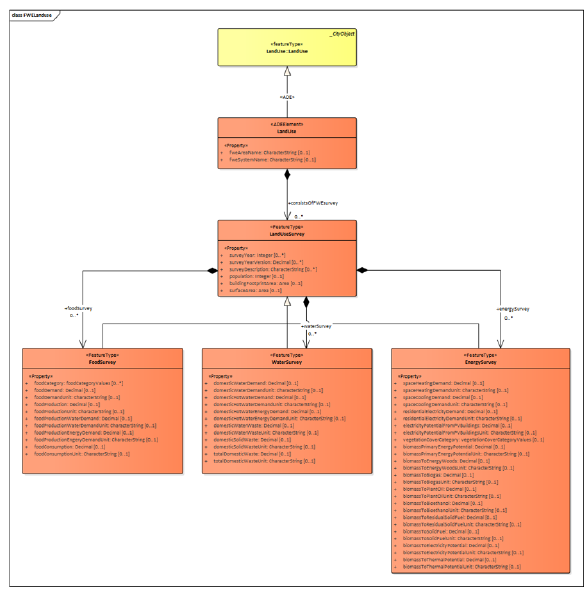
Figure 5. The UML class diagram for